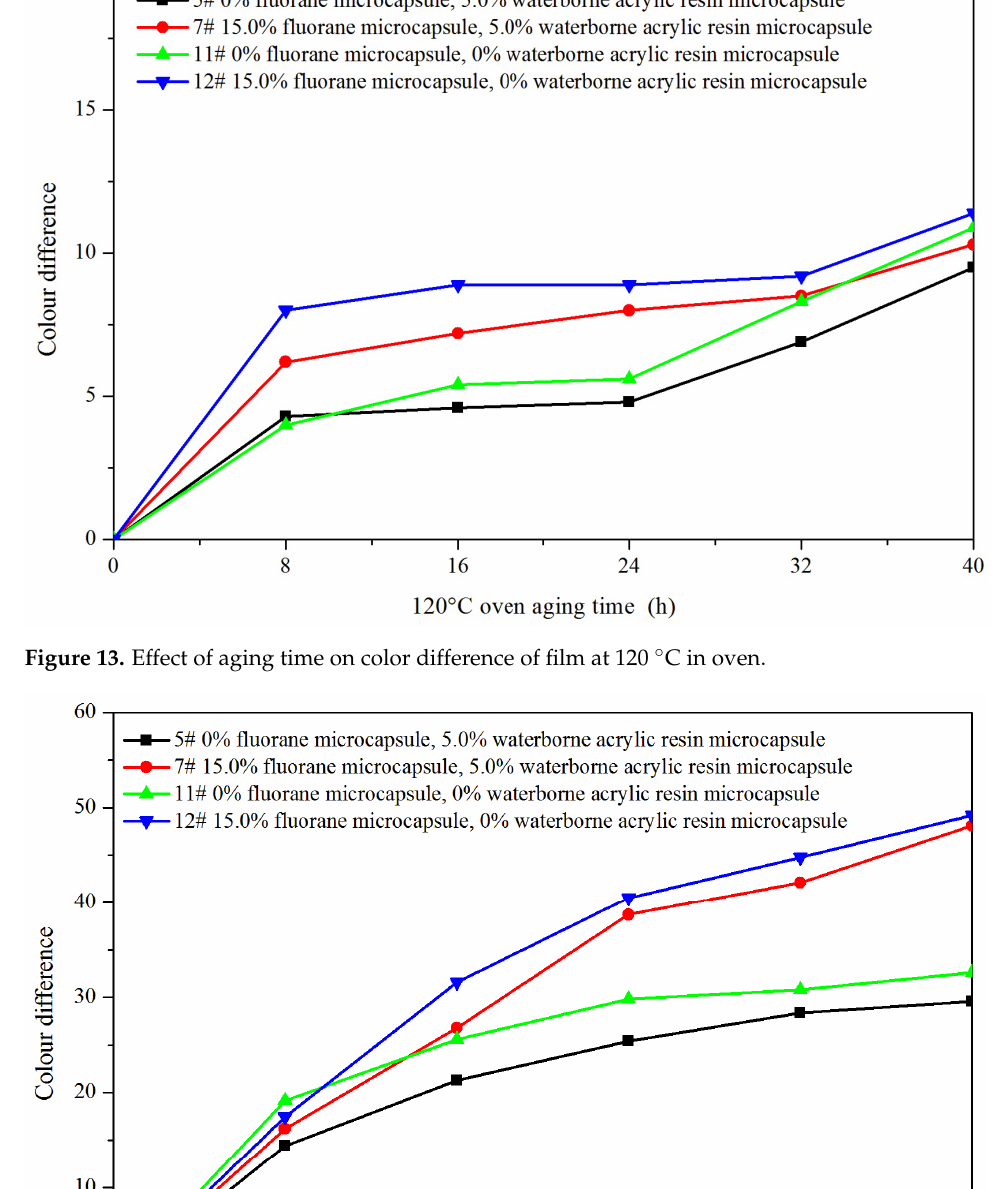
Figure 14. Effect of aging time on color difference of film at 160 °C in oven.